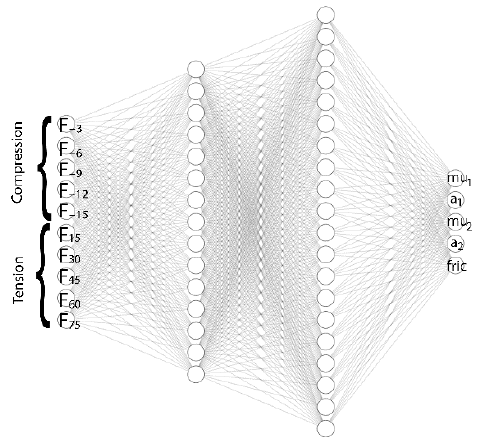
( b ) Figure 9. Virtual data sets: ( a ) Oring tension test and ( b ) Oring compression test. 3.2.2. ANN Model Development The force-displacement curves of the virtual data sets (100 cases) corresponding to the geometry-specific simulation, shown in Figure 9, were used to build the ANN in the commercial software of MATLAB 2021a. Specifically, the force values obtained from the O-ring tension and O-ring compression FEA simulations were selected as inputs, and Og-